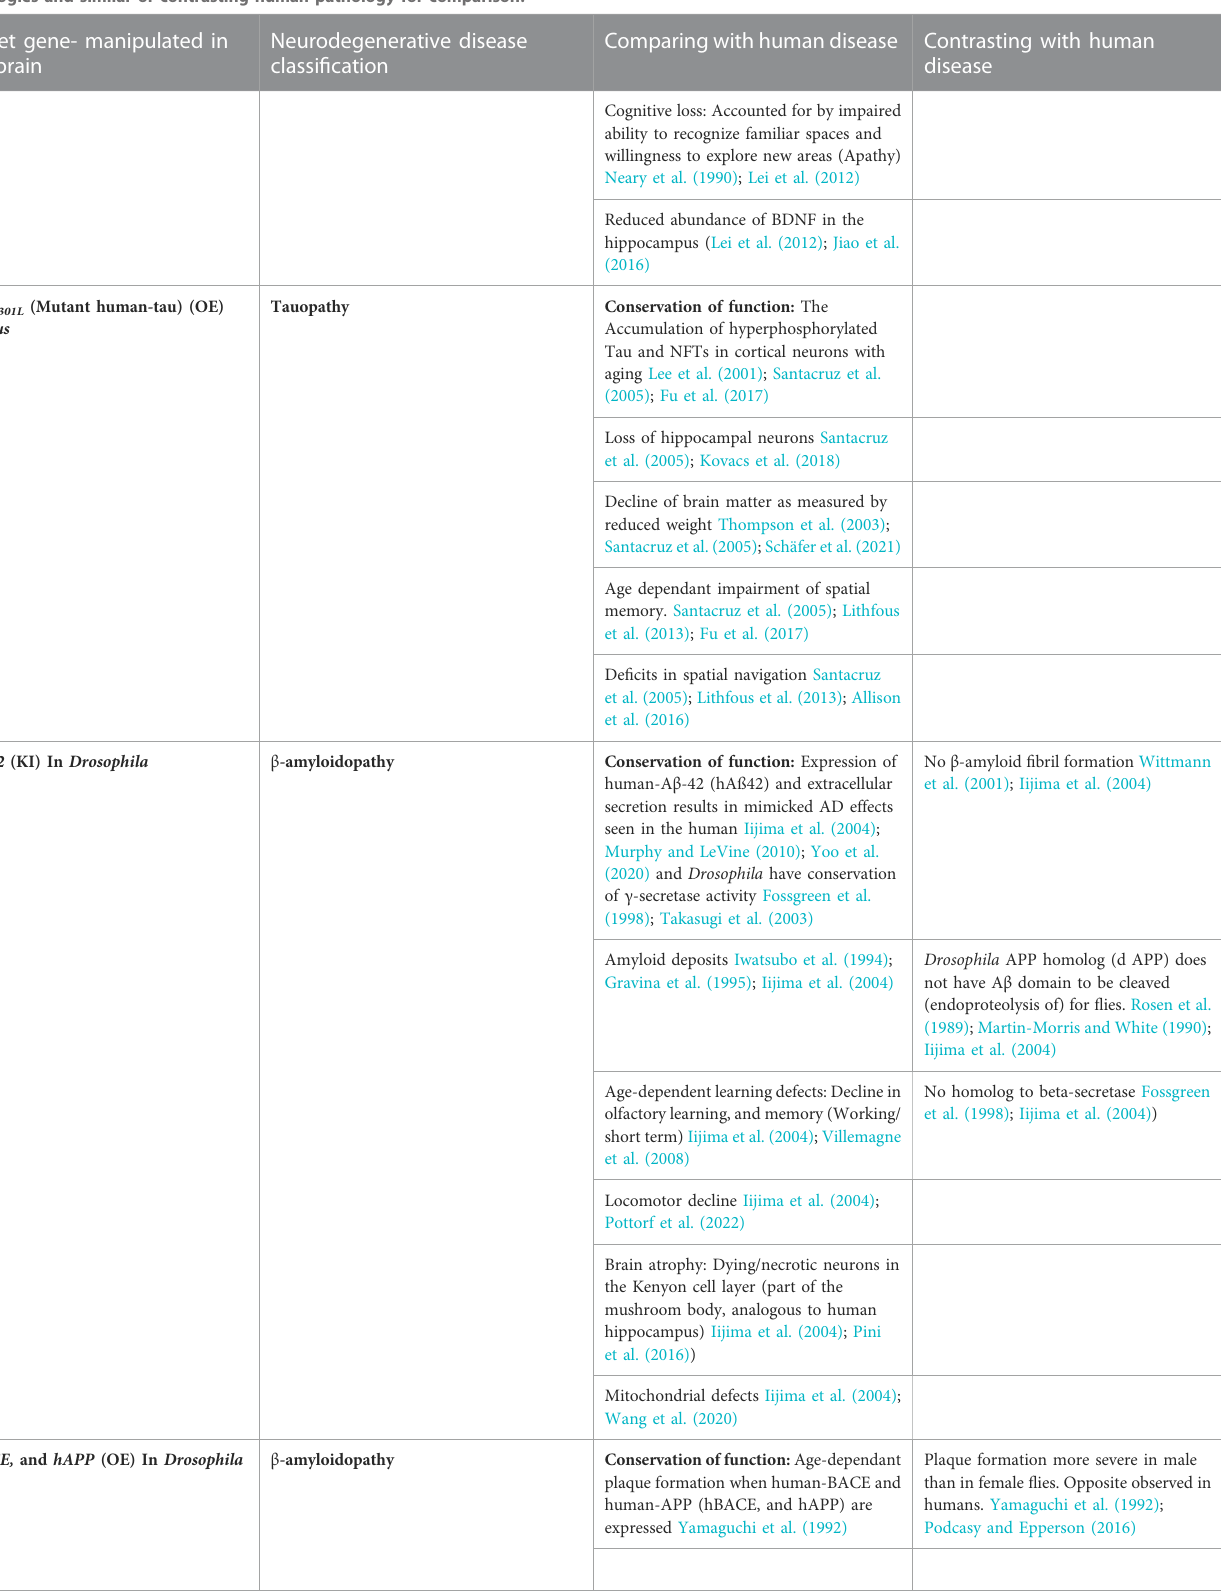
(OE) of hallmark genes for each of the three categories of neurodegenerative disease listed above. There is a column describing similarities in pathology between species and another column for differences. With each example made, there are references to the literature for more information about the model organism ’ s pathologies and similar or contrasting human pathology for